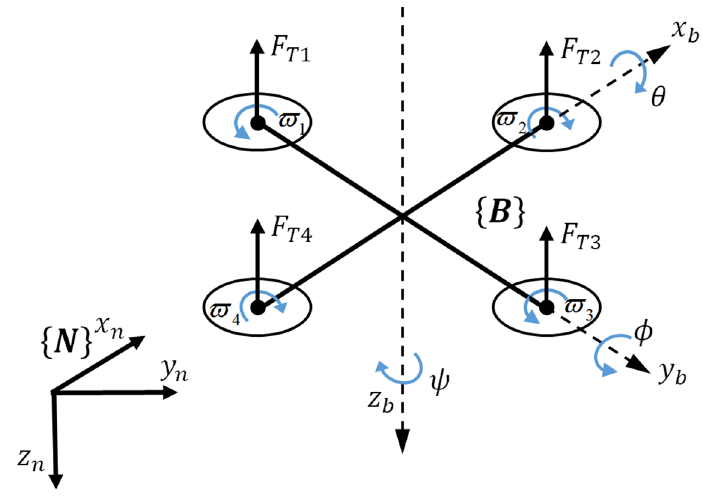
Figure 11. The quadrotor with corresponding frames.